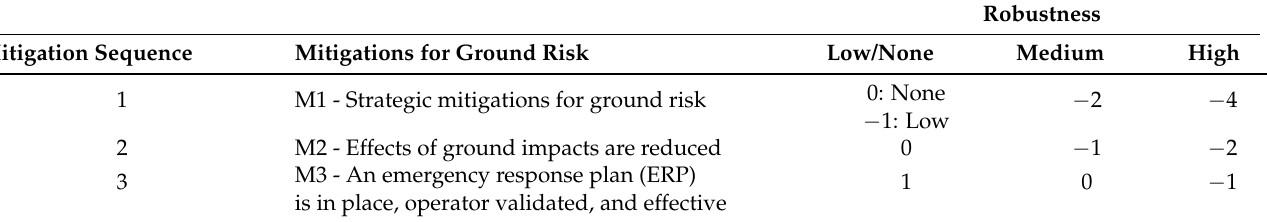
Table 3. Mitigations for final GRC determination